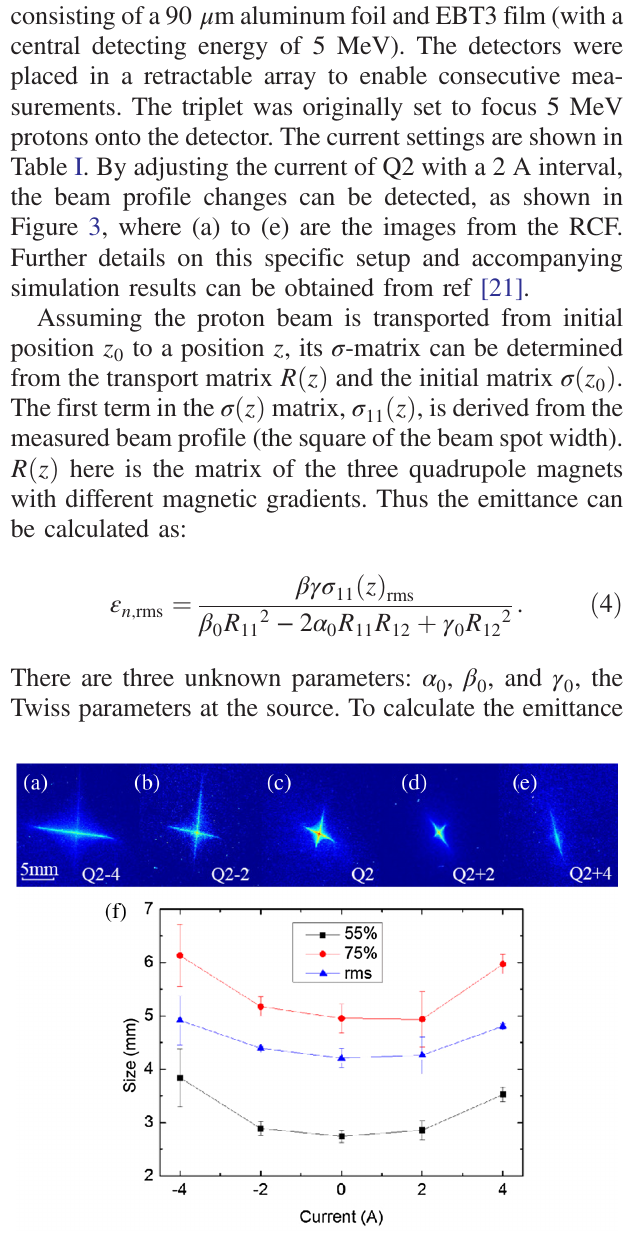
FIG. 3. Proton beam profile as detected by RCF using QST. Plots (a) – (e) show the profile with current shifts of − 4 A, − 2 A, 0 A, 2 A, and 4 A respectively applied to Q2, relative to the nominal current of − 248 . 74 A (see Table I). (f) Beam size in the y -direction for the same current